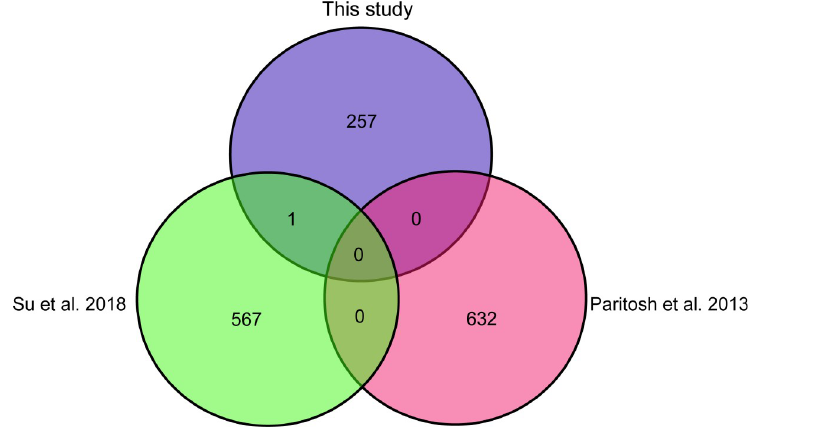
Fig 4. Comparison of KASP-SNP markers with those from previous studies.